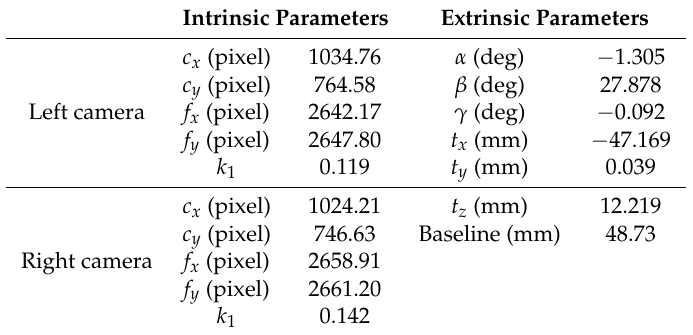
Table 1. The calibrated intrinsic and extrinsic parameters for the smartphone-based stereo-DIC system. Intrinsic Parameters